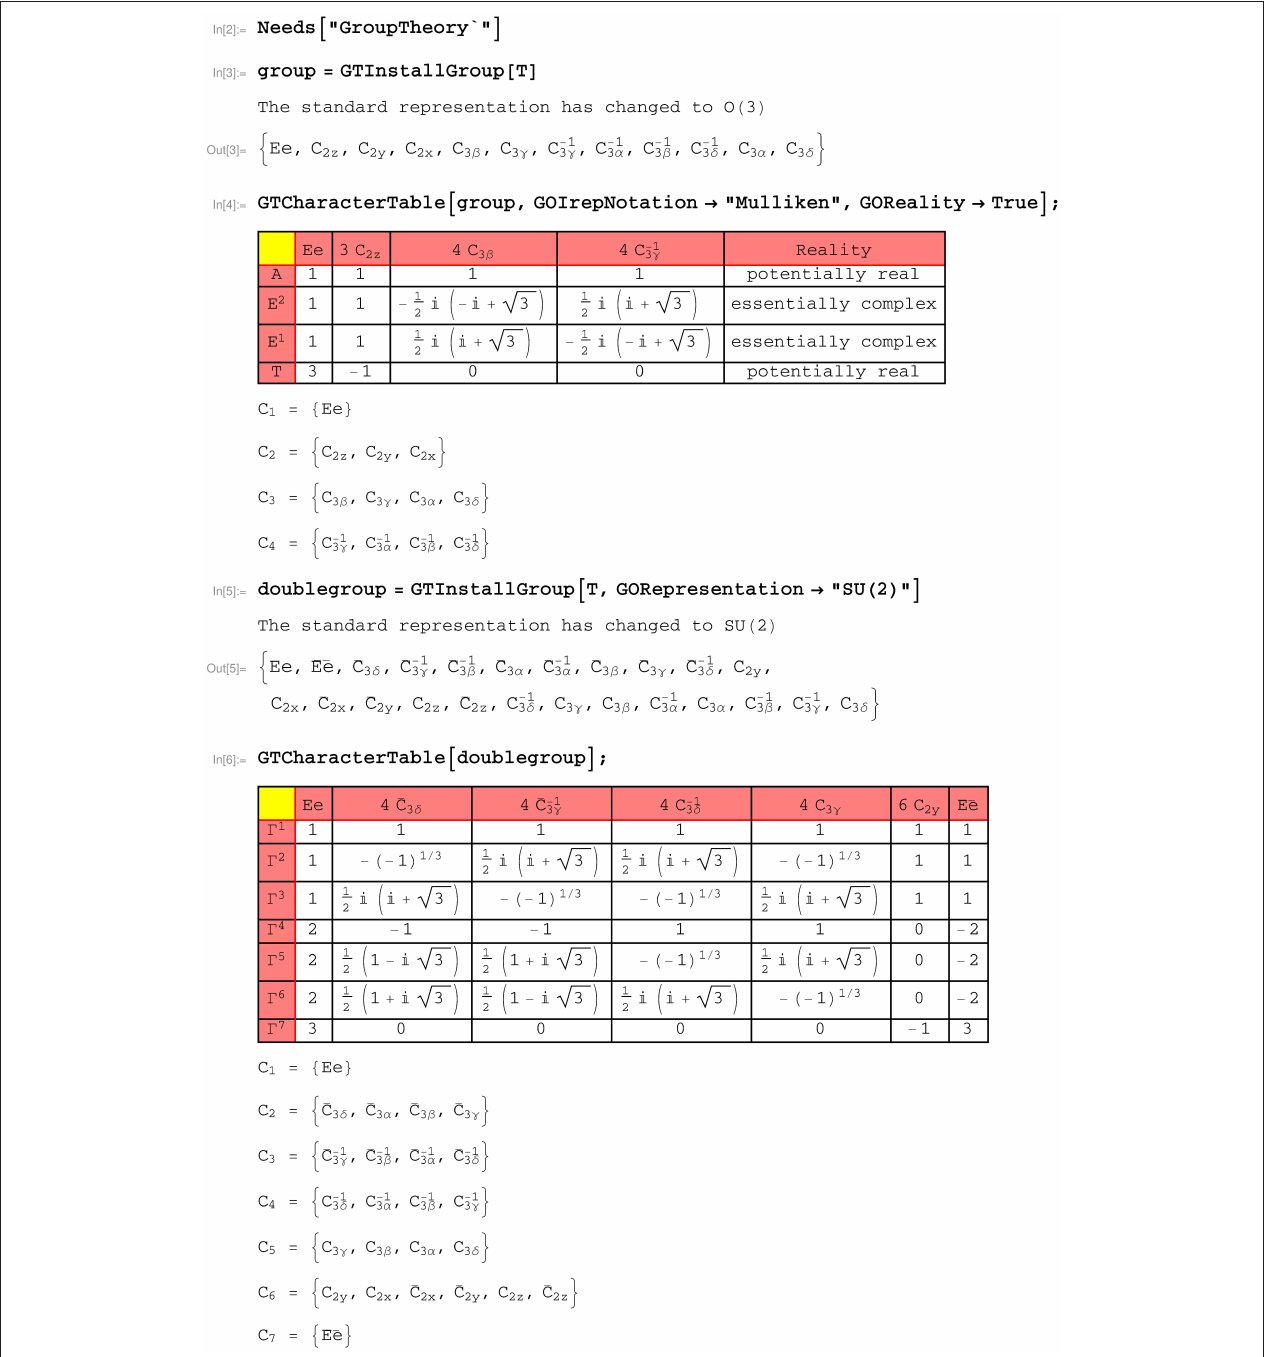
FIGURE 3 | Installation of groups and double groups and calculation of the character tables using the commands GTInstallGroup and GTCharacterTable